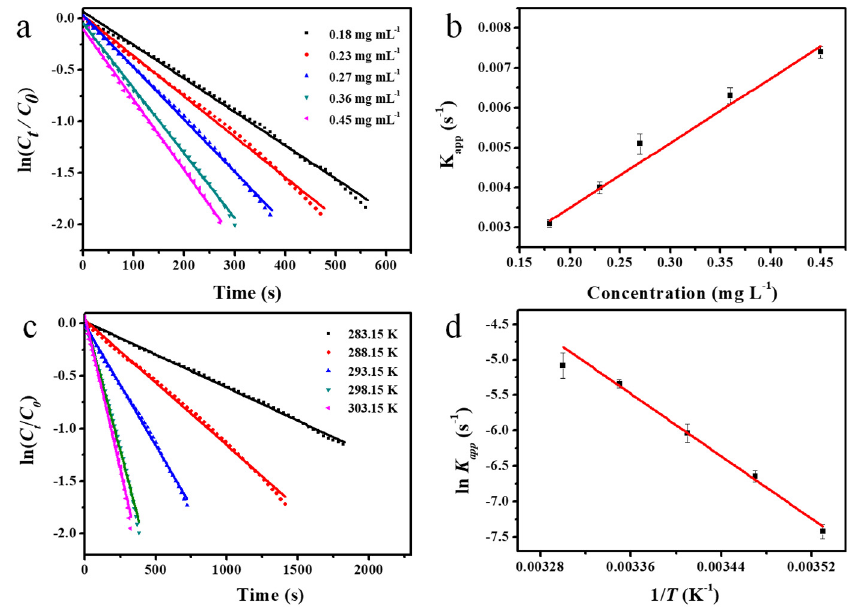
Figure 6. ( a ) Plots of ln ( C t / C 0 ) versus reaction time for the reduction of 4-NP catalyzed with di ff erent addition of hollow Ag@SiO 2 at 298.15 K (induction period of the reaction has been subtracted); ( b ) the apparent rate constant ( K app ) as a function of the concentration of catalyst; ( c ) plots of ln ( C t / C 0 ) versus reaction time for the reduction of 4-NP catalyzed with addition of hollow Ag@SiO 2 ([Ag] = 0.27 mg L − 1 ) at di ff erent temperatures (Induction period of the reaction has been subtracted); ( d ) plot of ln K app versus 1 / T .